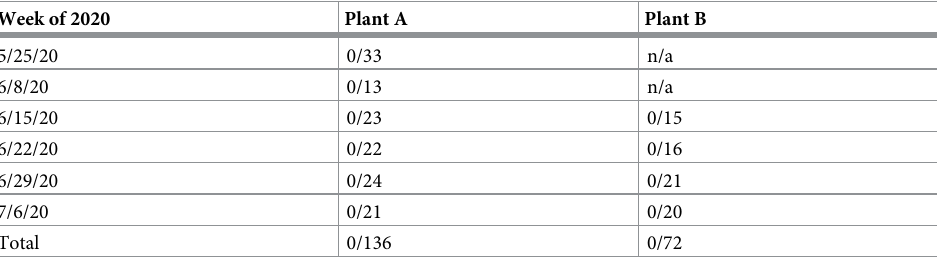
Table 1. Phase 1 surface and air sample